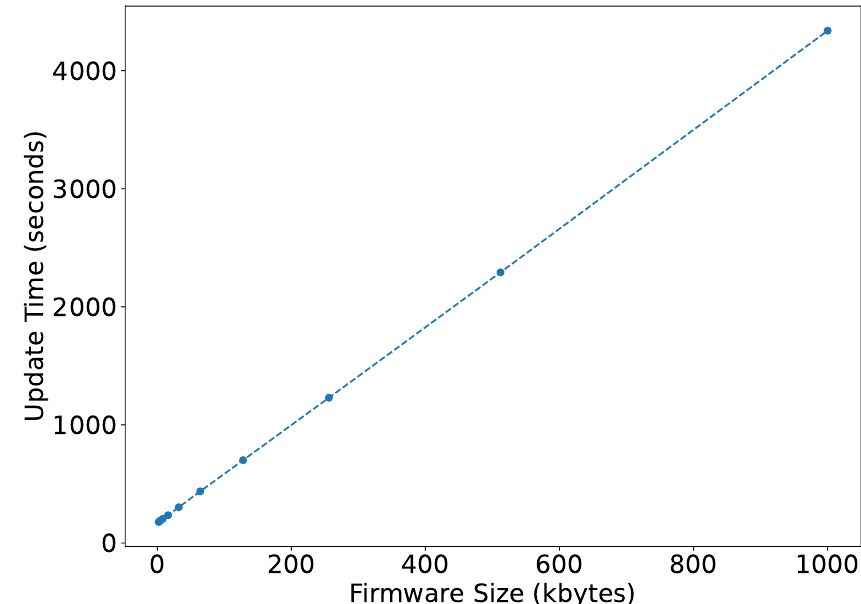
Figure 13. Firmware update